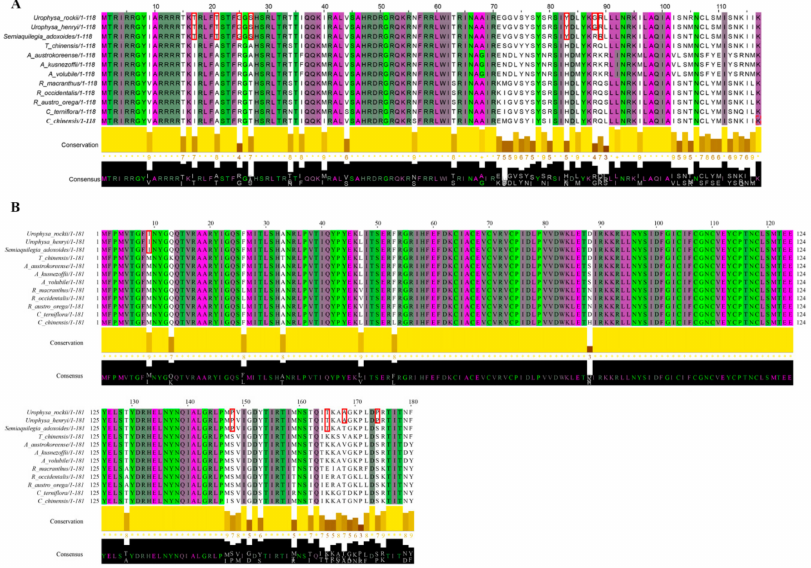
Figure 7. Two of the amino acids sequences that showed positive selection in the branch-site model test. ( A ) Amino acids sequences of the rpl20 gene; ( B ) amino acids sequences of the ndhI gene. The red blocks represent the different amino